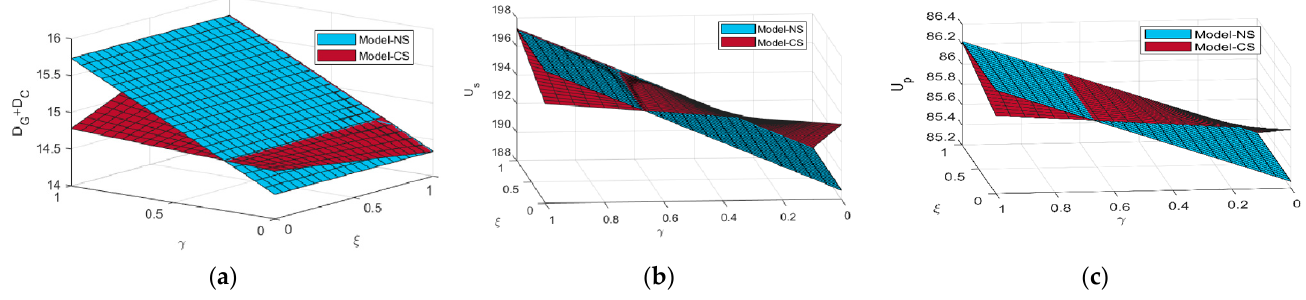
Figure 3. Effects of the competition intensity and the consumer subsidy ratio on performances under the CS scenario. ( a ) Total market demand for two types of agricultural products. ( b ) Supplier utility. ( c ) Platform utility.